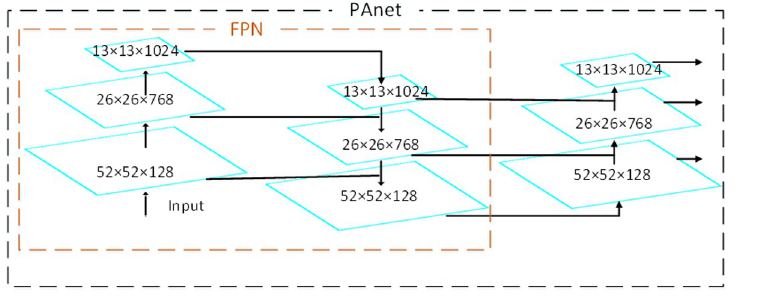
Fig 6. FPN and PANet network structure.